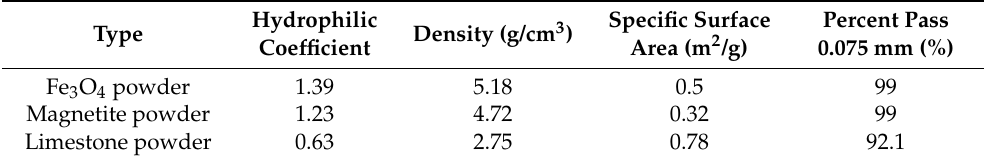
Table 3. Physical performance of fillers.